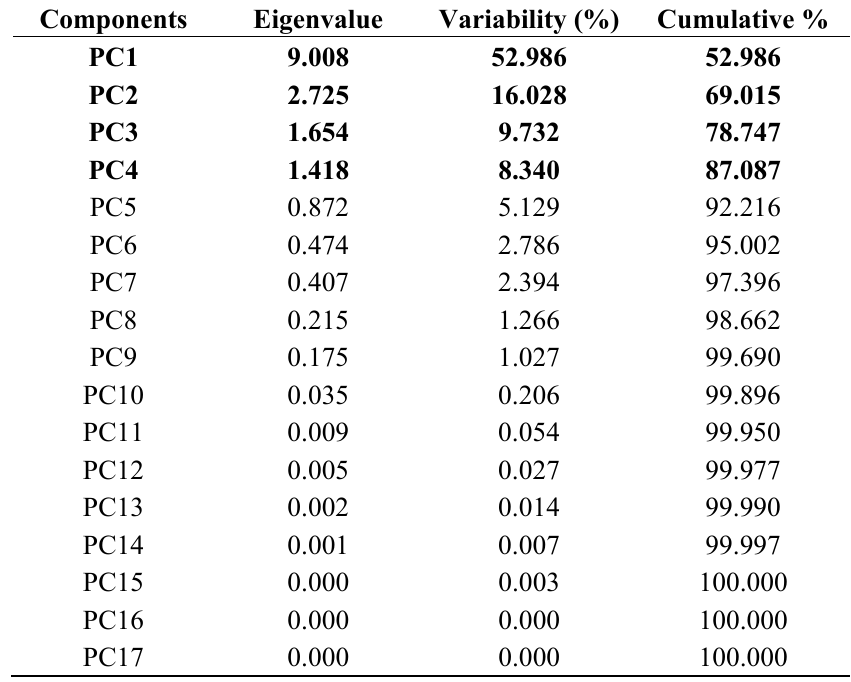
Table 4. Eigenvalue, variability and cumulative % of each of the extracted components. Components